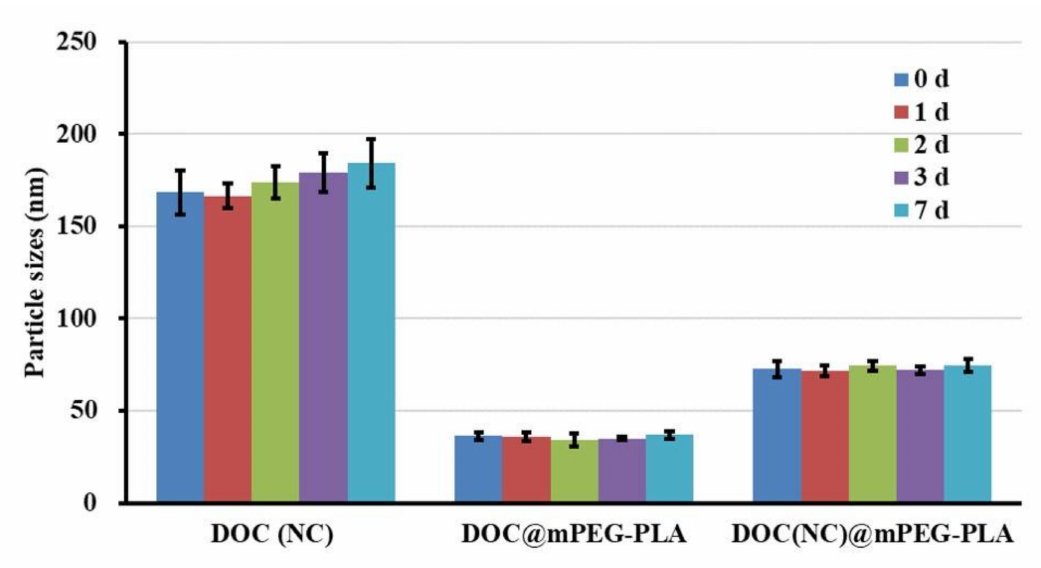
Figure 7. The particle sizes of DOC(Nc), DOC@mPEG-PLA, and DOC(Nc)@mPEG-PLA after holding at room temperature for 7 days. ( n =